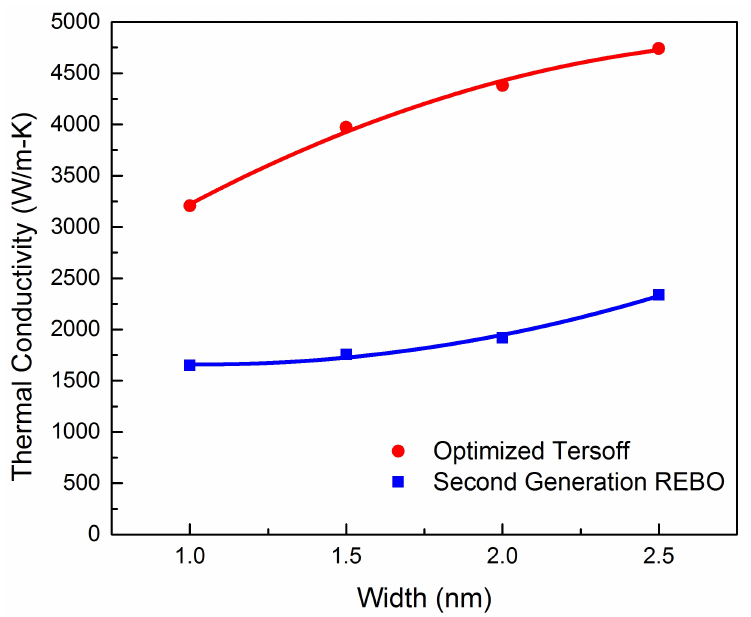
Figure 9. Thermal conductivity variation of GNR with width using optimized Tersoff and 2nd generation REBO potentials at 300 K temperature. The length of GNR is 10